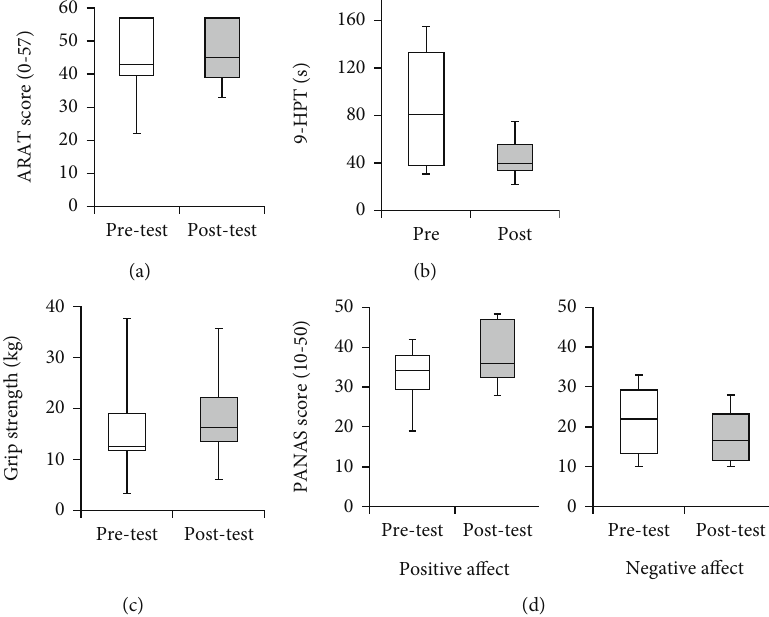
Figure 5: Box plots of the secondary outcome measures; (a) ARAT [55], (b) 9-HPT, (c) grip strength, and (d) PANAS [56]. Horizontal lines indicate the median values, boxes indicate the interquartile range, and vertical lines indicate the full